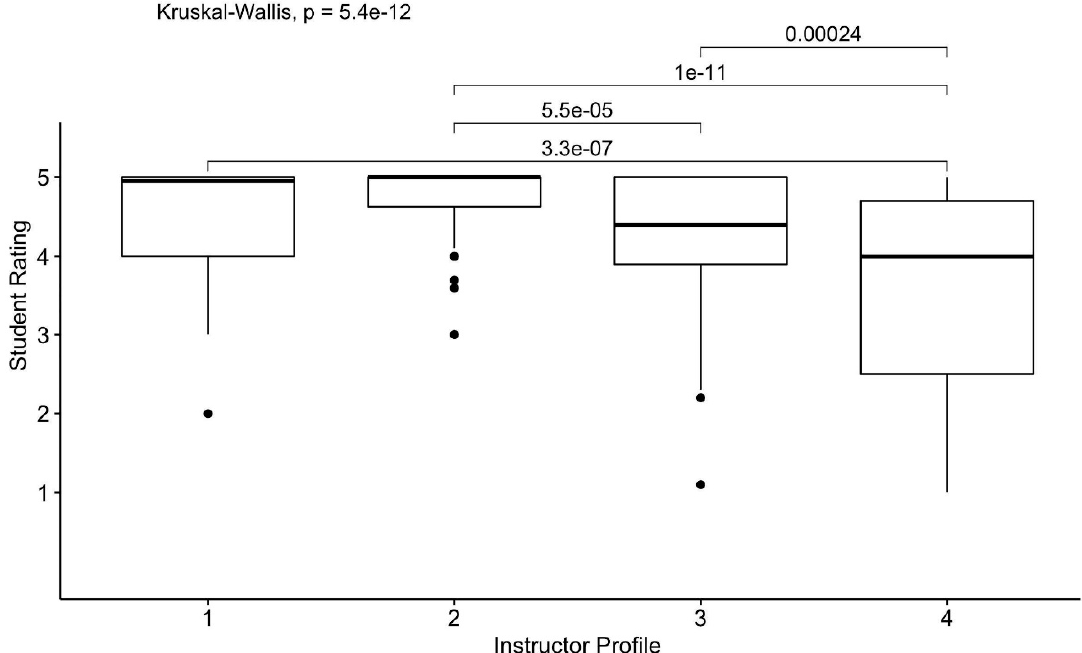
Figure 8. Ratings according to Face-to-Face Heritage Spanish course type and instructor profile. Instructor 1 is a native speaker from Spain, Instructor 2 is a native speaker from Latin America, Instructor 3 is a Heritage Speaker of Spanish, and Instructor 4 is an L2 Spanish speaker.